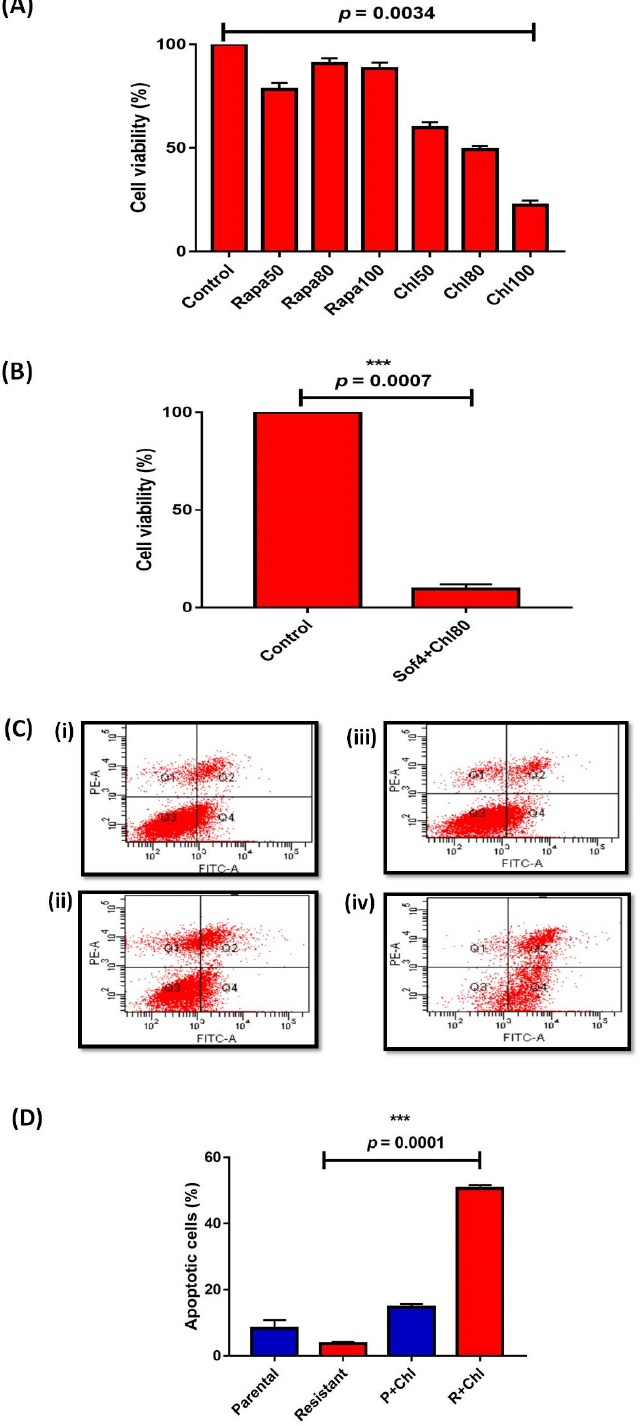
Figure 2. MTT assay showing ( A ) Percentage of cell viability in sorafenib resistant treated with different concentrations [(Rapa: Rapamycin (nM); Chl: Chloroquine ( µ M)] ( B ) Percentage of cell viability in presence of combination of sorafenib (Sof; IC 50 : 4 µ M) and chloroquine (Chl; IC 50 : 80 µ M) ( C ) Annexin V/PI assay showing cell apoptosis (i) Parental HepG2 cells (ii) sorafenib resistant HepG2 cells (iii) Parental+chloroquine (80 µ M) [P+Chl] (iv) sorafenib resistant+chloroquine 80 µ M [R+Chl] ( D ) Bar graph representation of percentage of apoptotic cells in HepG2 parental and resistant cells (** p ≤ 0.01; (*** p ≤